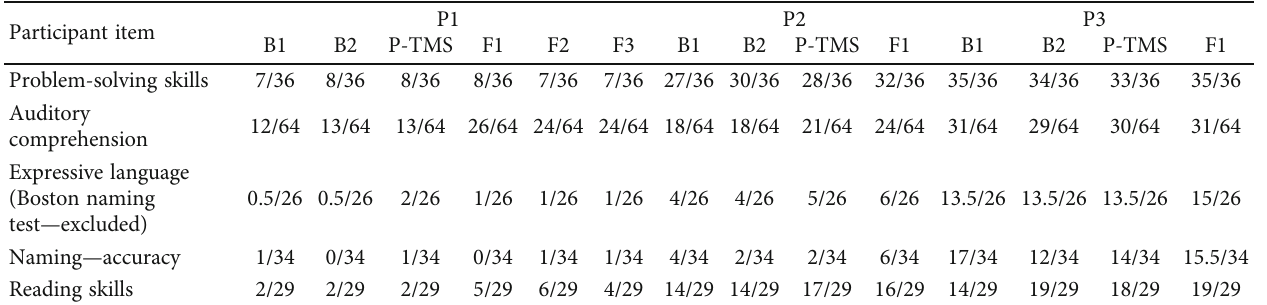
Table 2: Categorical language and cognitive scores at posttreatment and follow-up compared to baseline for P1, P2, and P3. Participant item Problem-solving skills Auditory